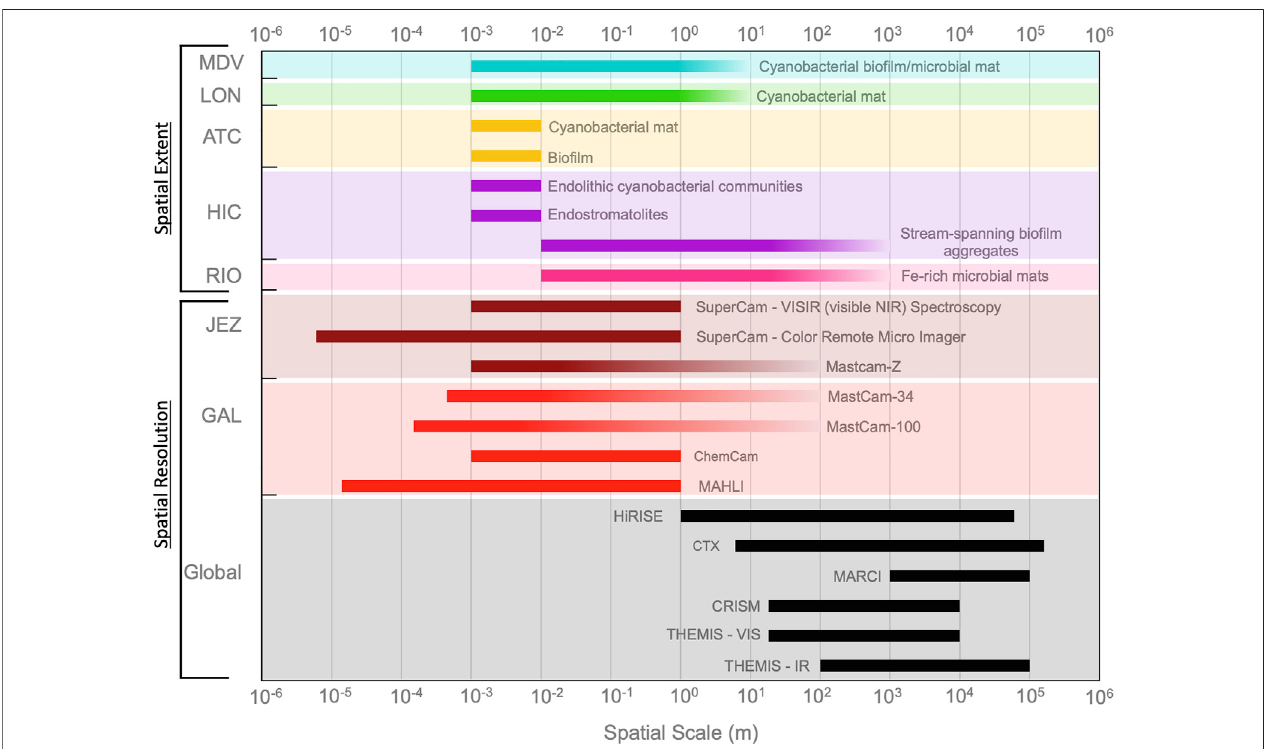
FIGURE 6 | Spatial extent of macrobiological features at each analog site compared to the spatial resolution of imaging instrumentation on the Curiosity rover in Galecrater,the Perseverance roverinJezerocrater,andglobaldatasetsfromtheMarsReconnaissanceOrbiterandMarsOdysseyOrbiter.Rover-scaleinstrumentation would be required to spatially resolve the majority of macrobiological features at analog sites. See Supplementary Tables S1, S4 for details on Mars instruments and analog macrobiological features, respectively.